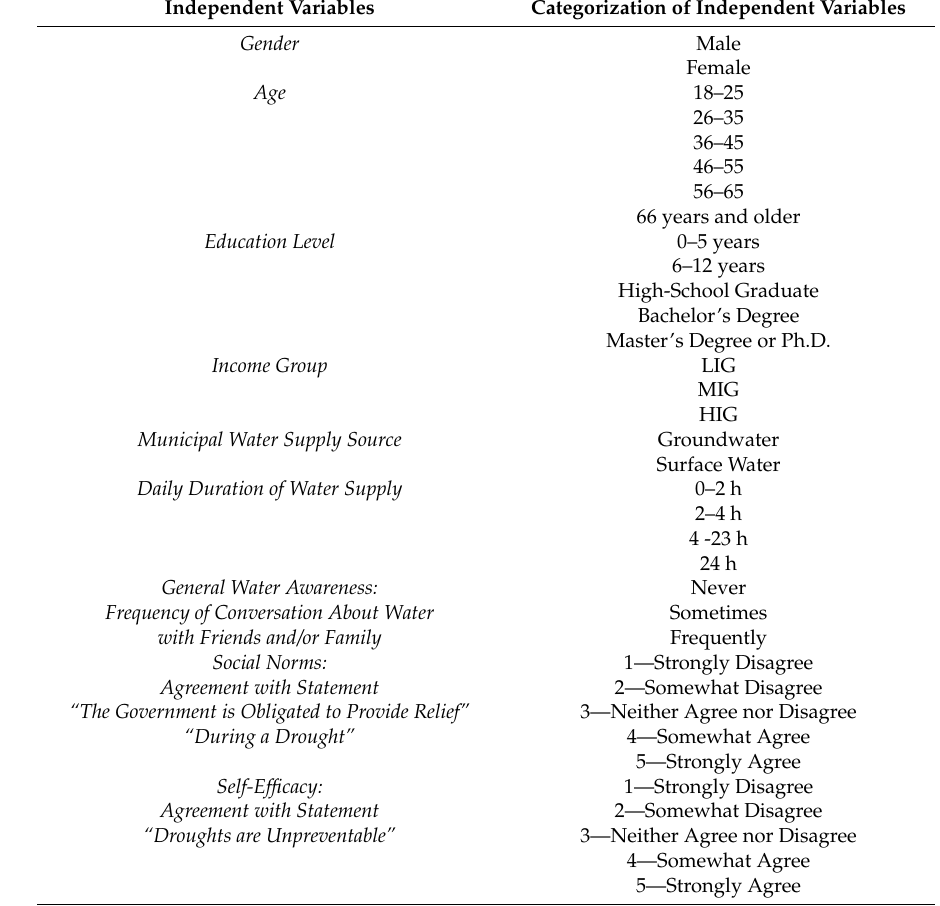
Table 5. Categorization of independent variables for statistical analysis (both multivariate analysis of variance (MANOVA) and logistic regression).